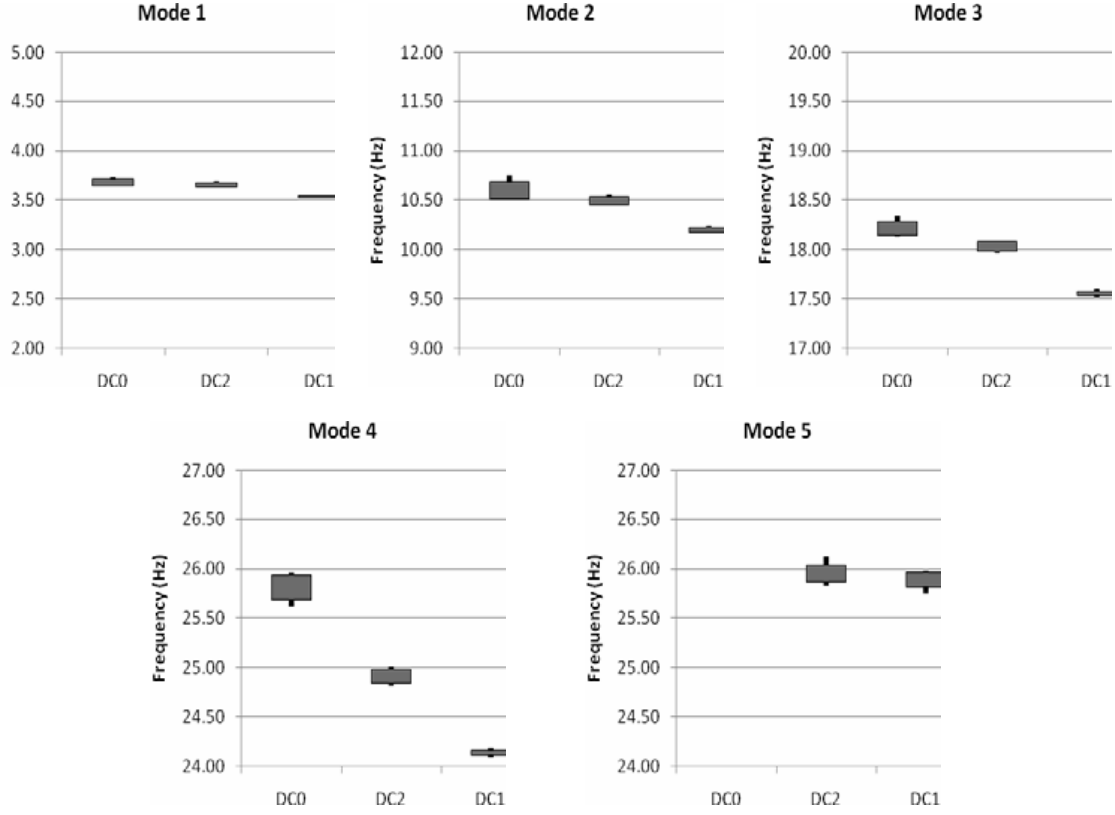
Fig. 16. Evolution of identified frequencies due to damage (OKID); solid bars signify µ ± σ range and error bars signify minimum and maximum